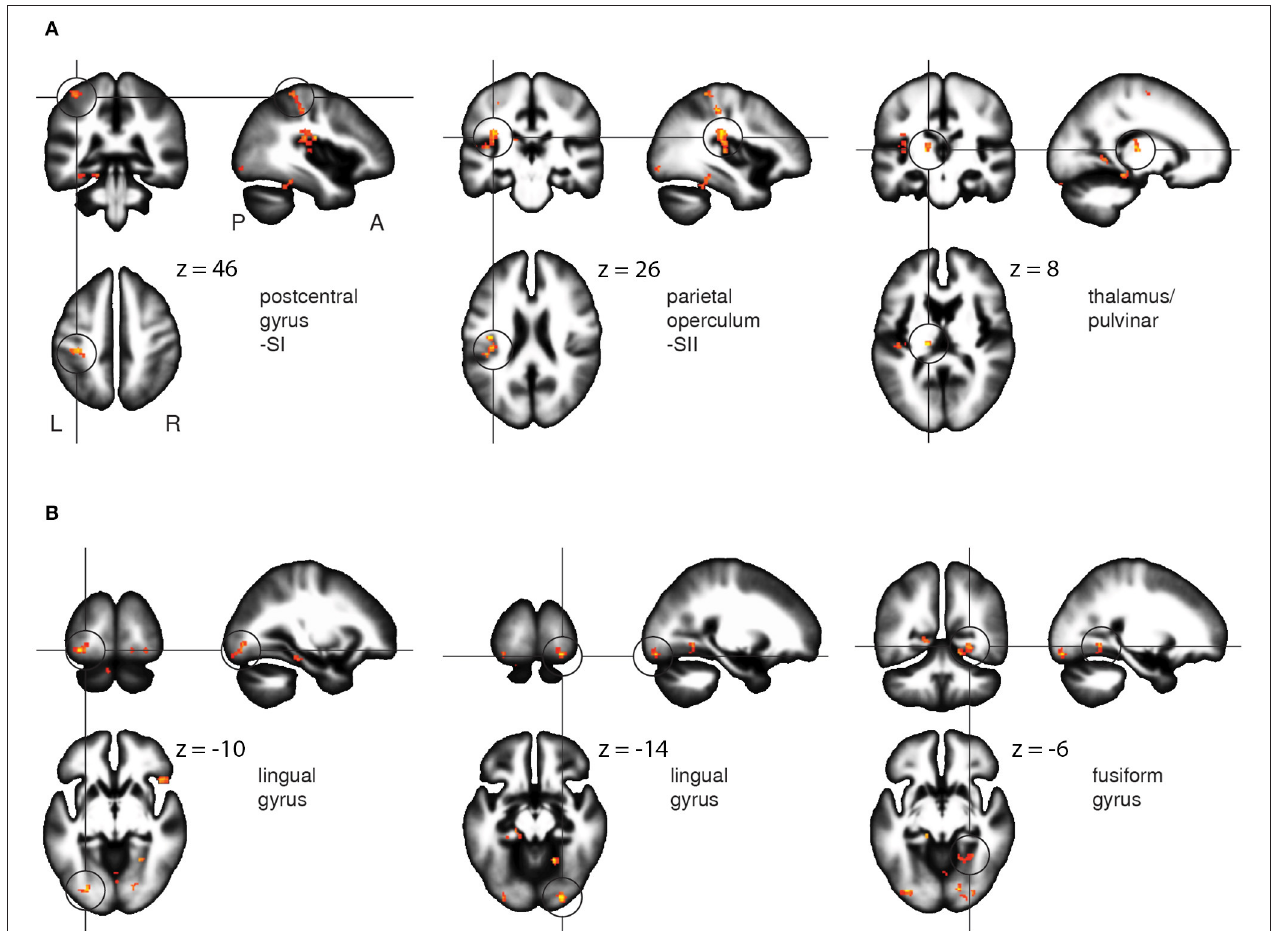
FIGURE 5 | FA results. White matter areas showing an increase of fractional anisotropy as a result of the Braille training, within somatosensory (A) and the ventral stream (B) regions. Results revealed by paired t -test between the FA maps before and after the training. Statistics presented on the sagittal (x), coronal (y), and axial (z) slices of the white matter tissue template (MNI). FWE corrected at p < 0.05, k =